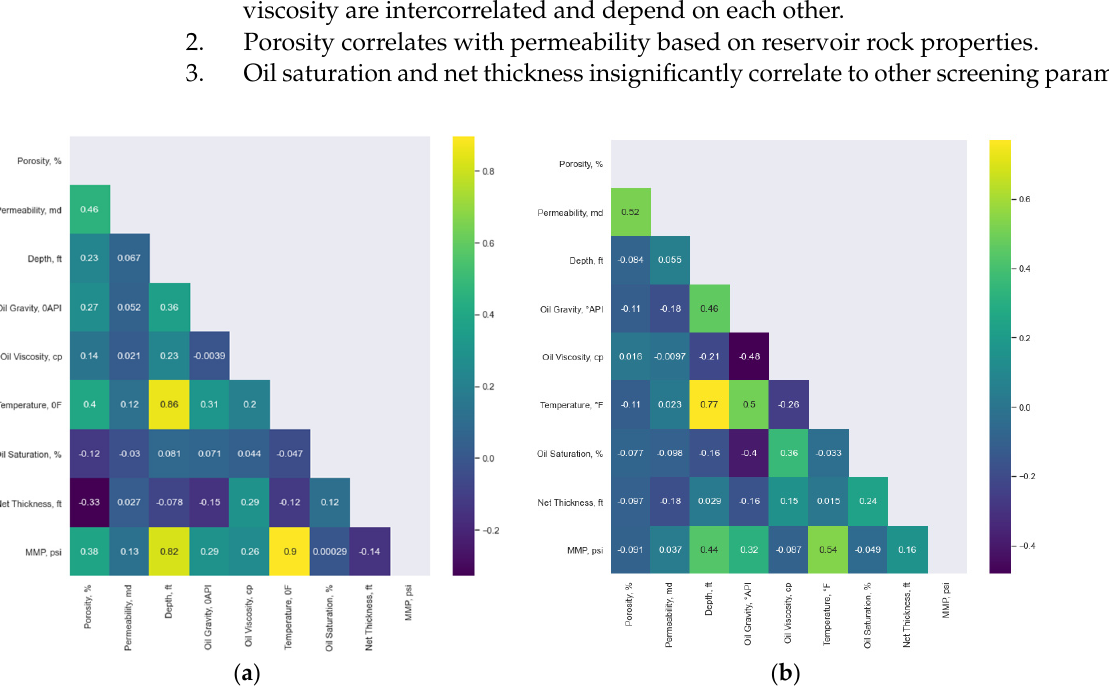
Figure 5. Heatmap of Pearson correlation: ( a ) miscible CO 2 -EOR; ( b ) immiscible CO 2 -EOR.